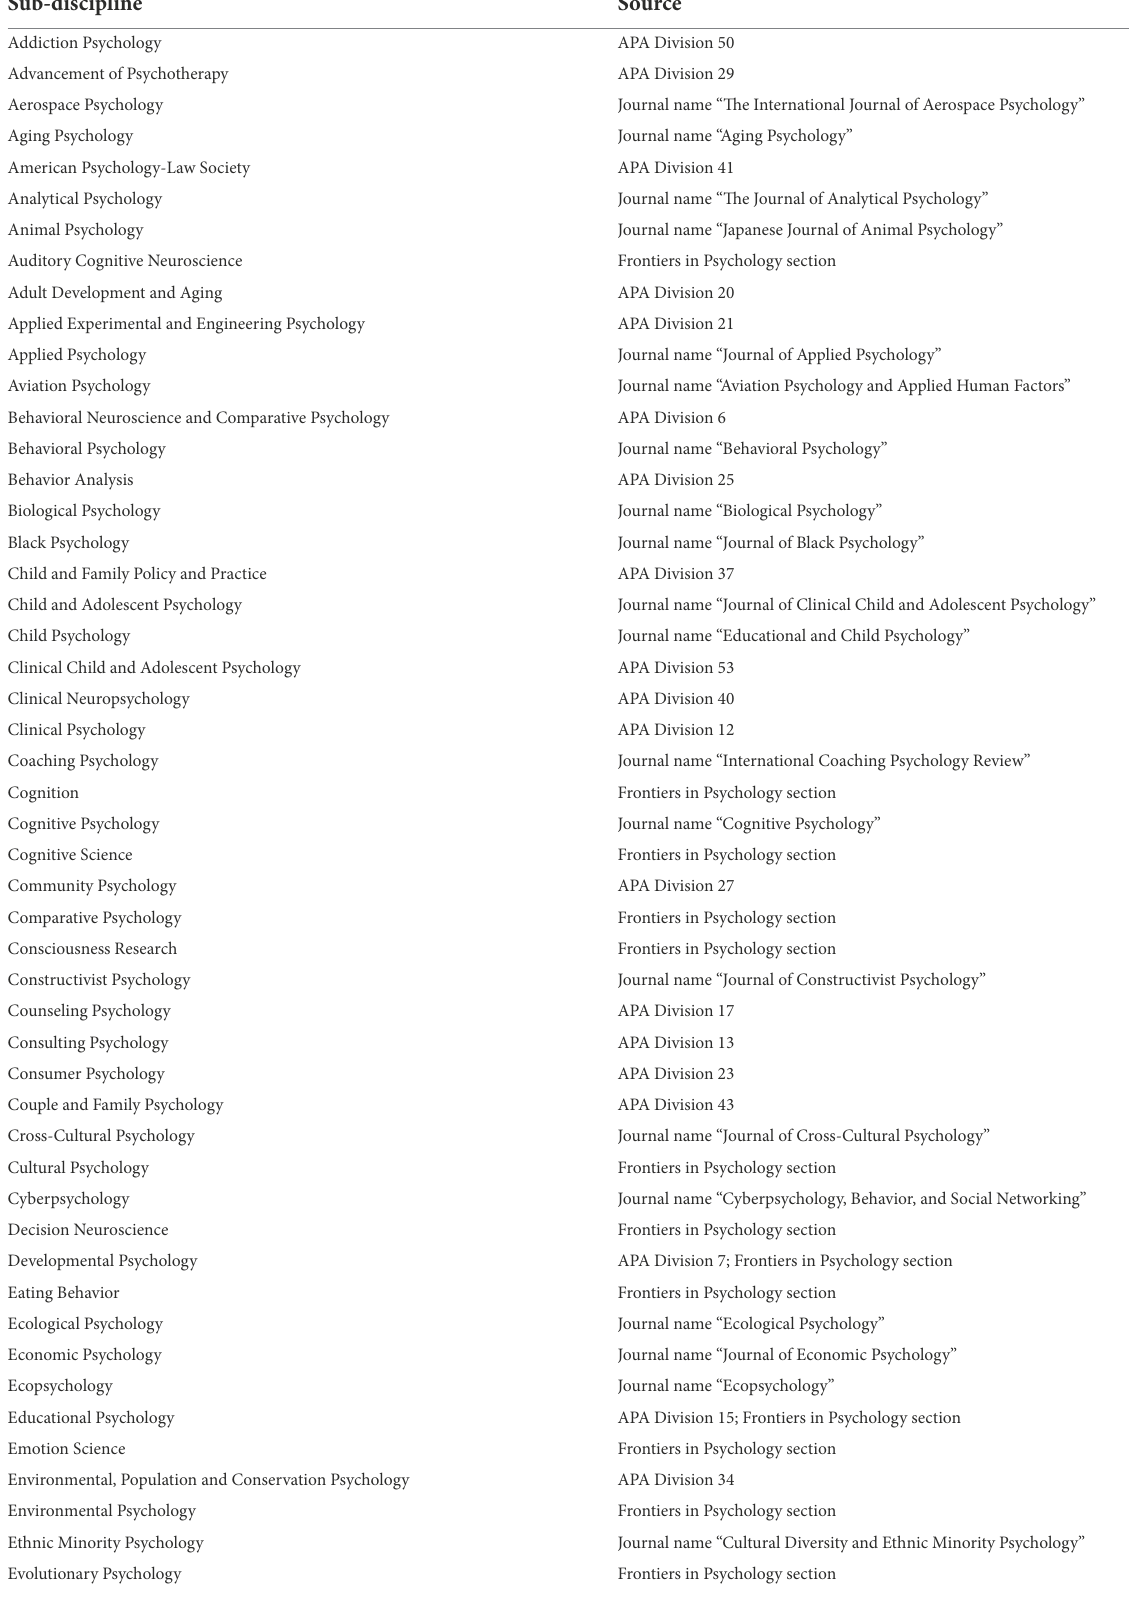
TABLE 1 Sub-disciplines and special interest groups of psychology as presented by Frontiers in Psychology , APA , and in academic journal titles. Sub-discipline